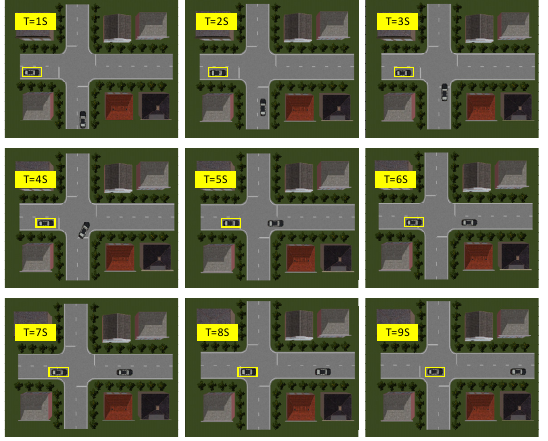
Figure 18. Simulation animation of condition I.